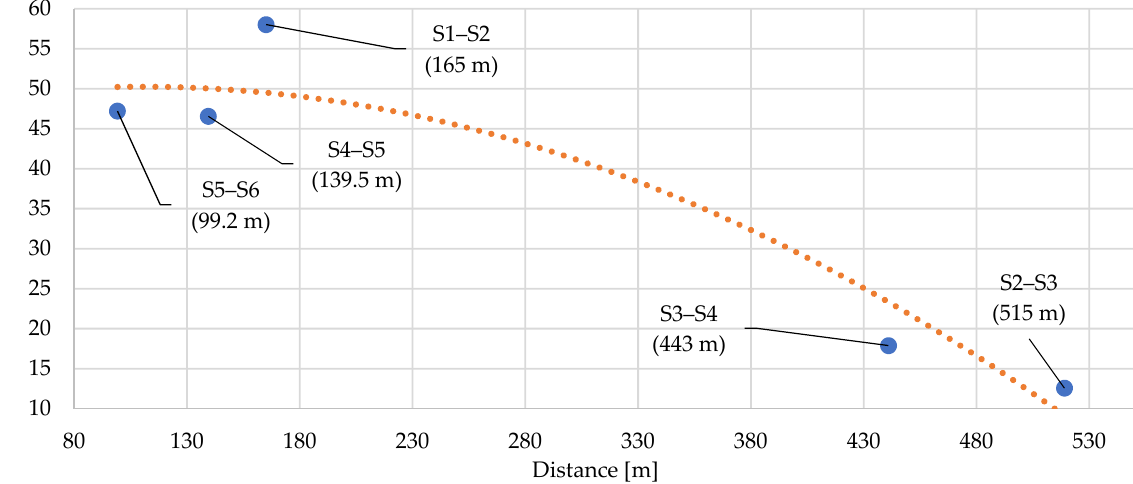
Sensors 2021 , 21 , x FOR PEER REVIEW Figure 11. Impact of distance on UDP/IP throughput with the theoretical trend line interpolation.